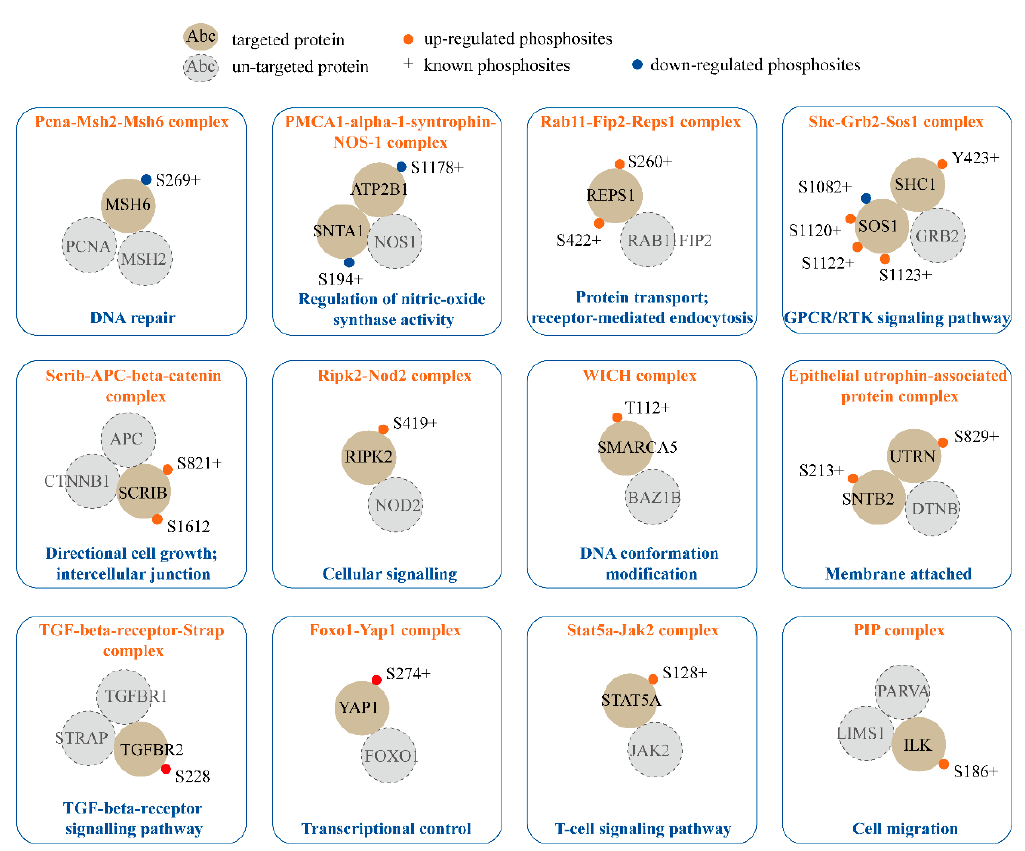
Figure 4. SPRY regulates phosphorylation in the established protein complexes variably. Twelve complexes participating in di ff erent cellular processes are selected and annotated according to GO-based descriptions. The 12 complexes encompass 15 proteins with 20 phosphosites. Khaki circles indicate targeted proteins in the phosphoproteome. Gray circles indicate proteins that are not targeted. Orange dots represent up-regulated phosphosites and down-regulated phosphosites are marked with blue dots. Previously reported phosphosites are labeled with “ + ”. WICH complex: WSTF-ISWI chromatin remodeling complex; PIP complex: PINCH-1 / 2 / ILK / α -parvin